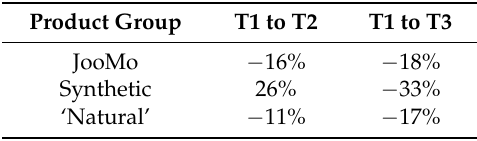
Table 6. Average percentage change in moisture on the skin for all product